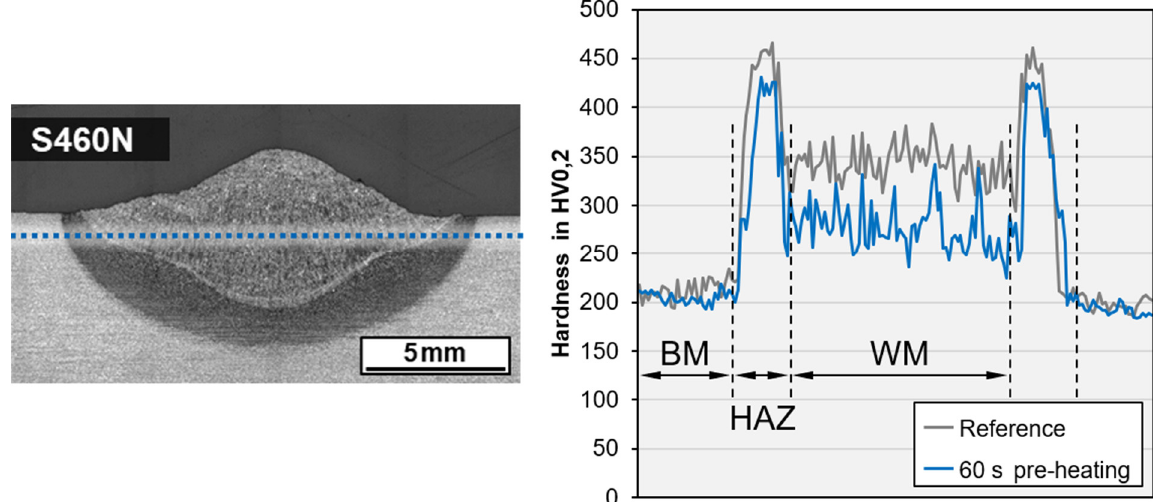
Figure 8. Macro section of wet SMAW on S460N with test indication and comparison of hardness data without induction heating and with PH ( WD = 0.5 m, h = 10 mm, E = 1.85 kJ/mm).